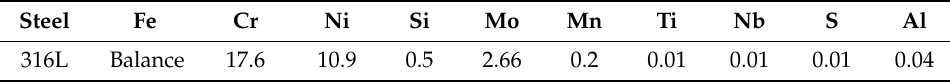
Table 1. Table 2 contains the particle size percentiles and true densities of the raw materials. Table 1. Composition of 316L stainless steel powder (in wt